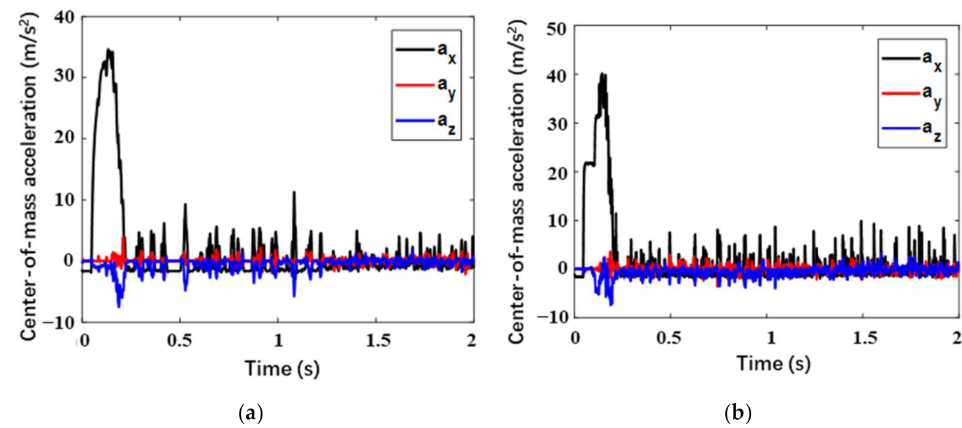
Figure 11. Center-of-mass acceleration of lunar lander in Case 1 within ( a ) buckypaper and ( b ) aluminum honeycomb.